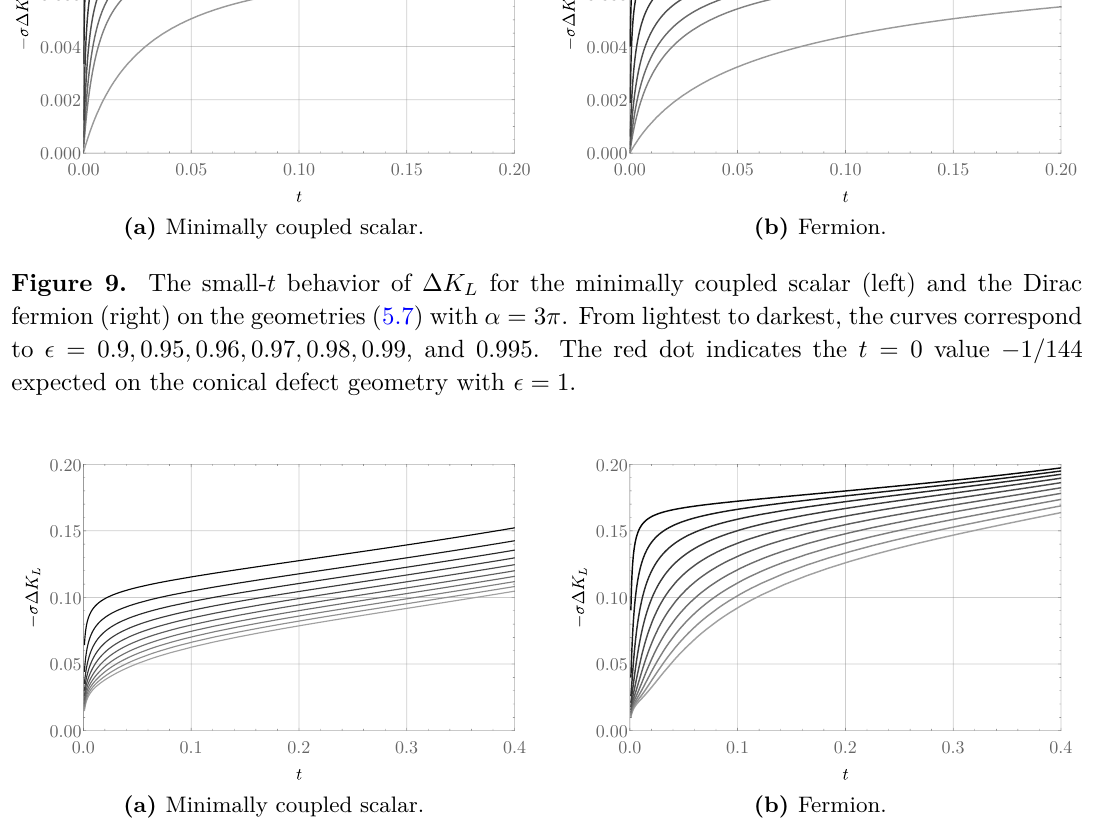
Figure 10. The behavior of ∆ K L at small t for ‘ = 2 and (cid:15) > 0 for the minimally coupled scalar (left) and the Dirac fermion (right). From lightest to darkest, the curves correspond to (cid:15)/(cid:15) max = 0 . 9 to 0 . 99 in intervals of 0 . 01